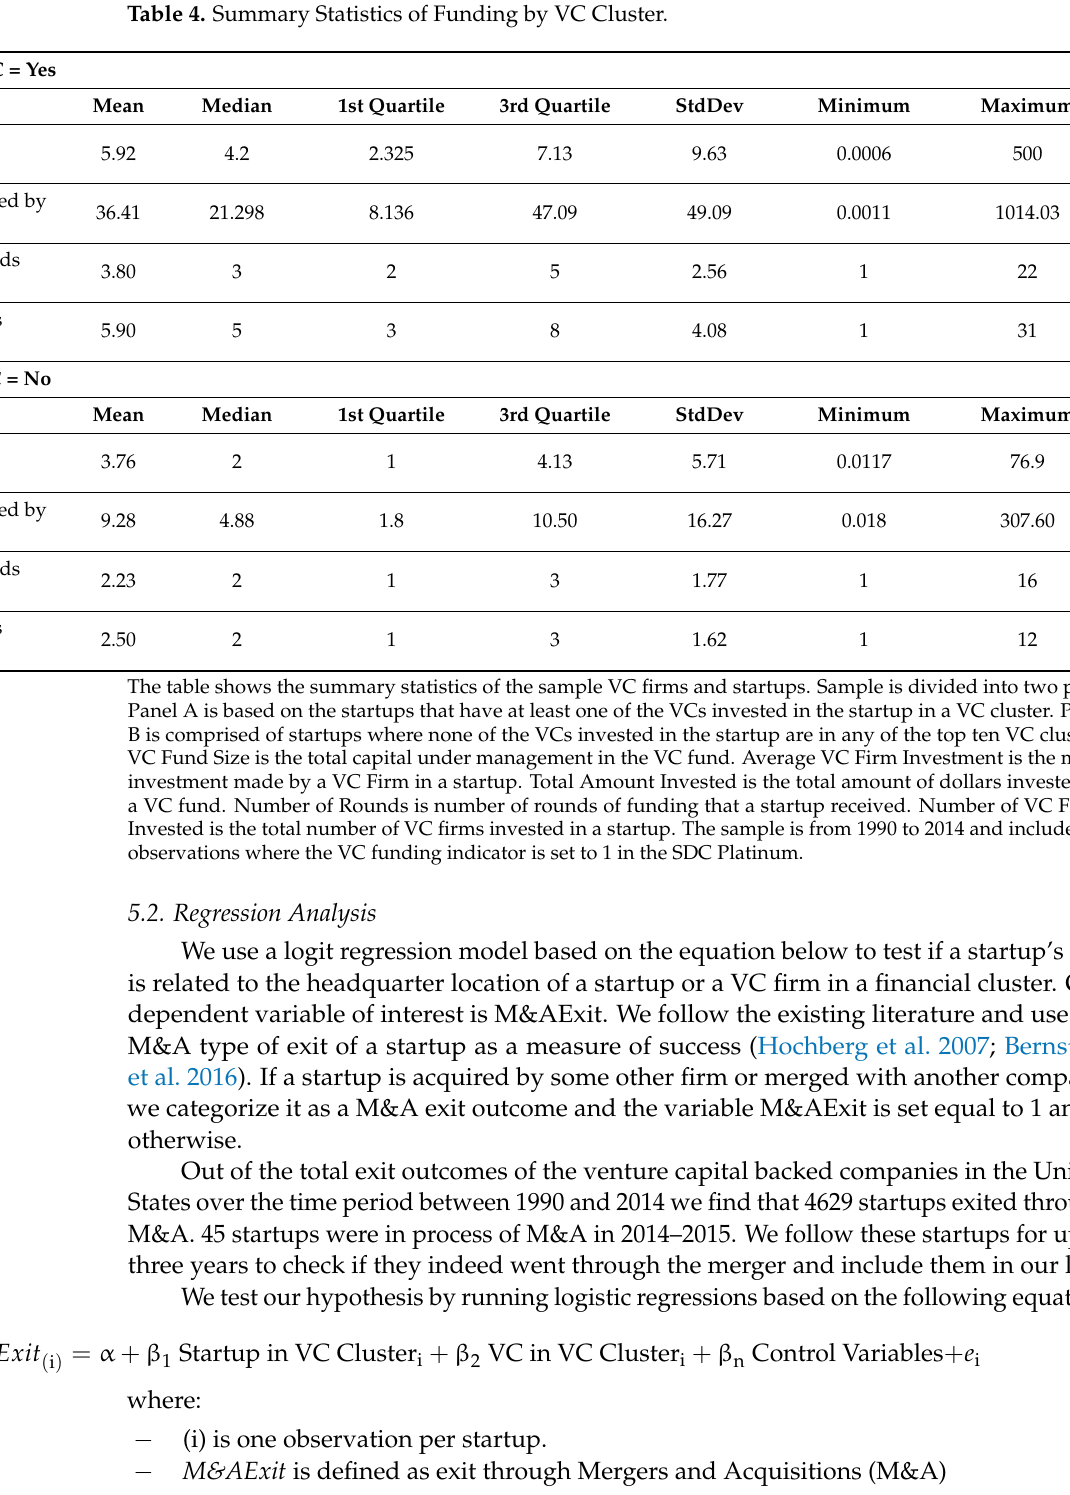
Table 4. Summary Statistics of Funding by VC